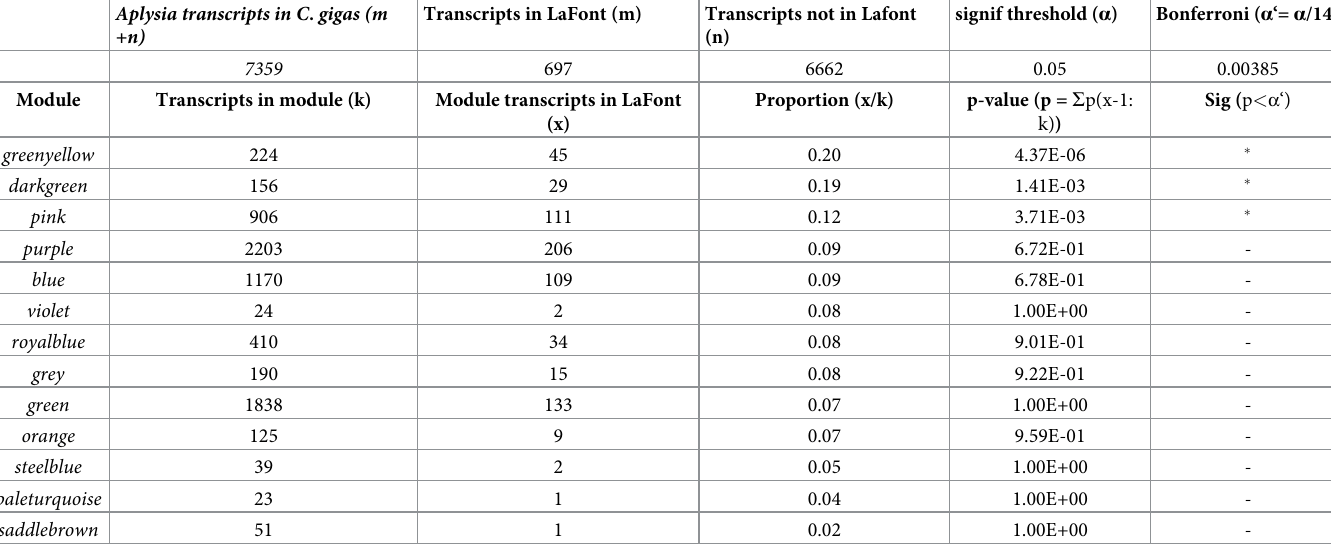
Table 7. Aplysia co-expression module enrichment for orthologs differentially expressed after immune priming and viral challenge in pacific oyster Crassostrea gigas